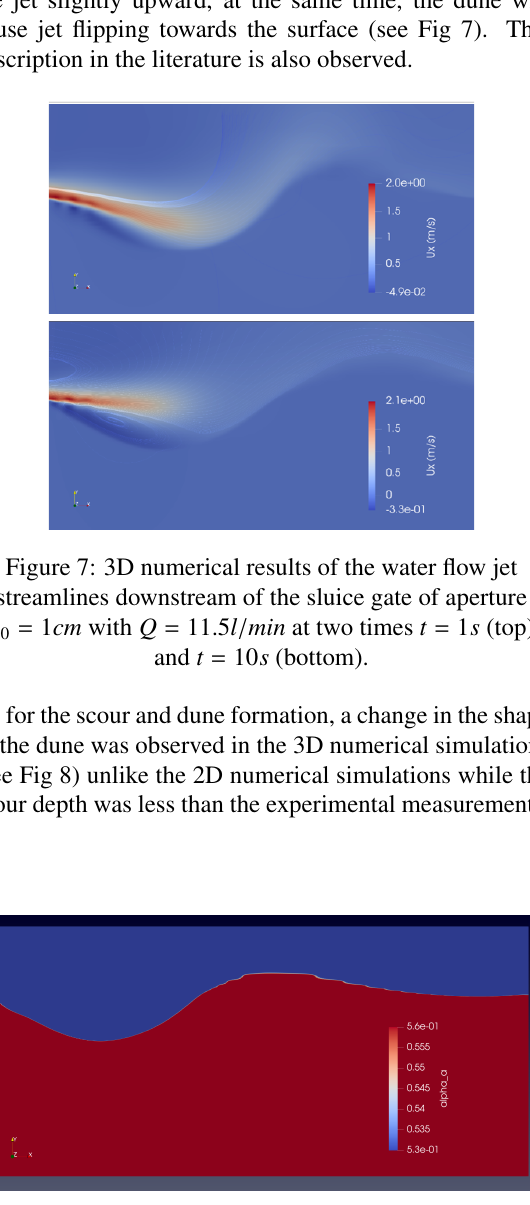
Figure 8: 3D numerical results of the scour and dune formation with Q = 11 . 5 l / min and b 0 = 1